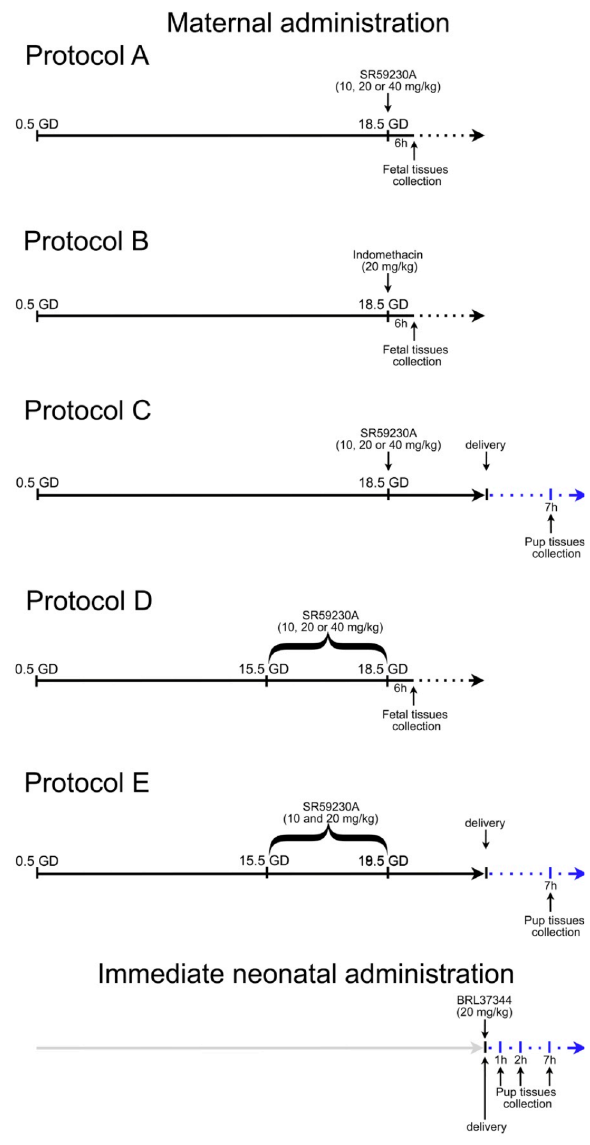
Figure 1. Drug treatment protocols. Maternal administration: seven dams per group were treated at the indicated gestation days (GD) (day 0.5 = presence of vaginal plug). Protocols A and B studied the e ff ects of a single dose of SR59230A or indomethacin respectively on 18.5 GD on fetal ductus arteriosus (DA) (tissues harvested 6 h after treatments); protocol C studied the e ff ects of a single dose of SR59230A on 18.5 GD on newborn DA (tissues harvested 7 h after delivery); protocol D studied the e ff ects of maternal prolonged SR59230A exposure (daily treatment from GD 15.5 to 18.5) on fetal DA (tissues harvested 6 h after the last treatment); protocol E studied the e ff ects of prolonged maternal exposure to SR59230A (daily treatment from GD 15.5 to 18.5) on newborn DA (tissues harvested 7 h after delivery). Immediate neonatal administration: newborn mice were injected with BRL37344 within 2 min after birth and tissues were harvested after 1 h, 2 h and 7